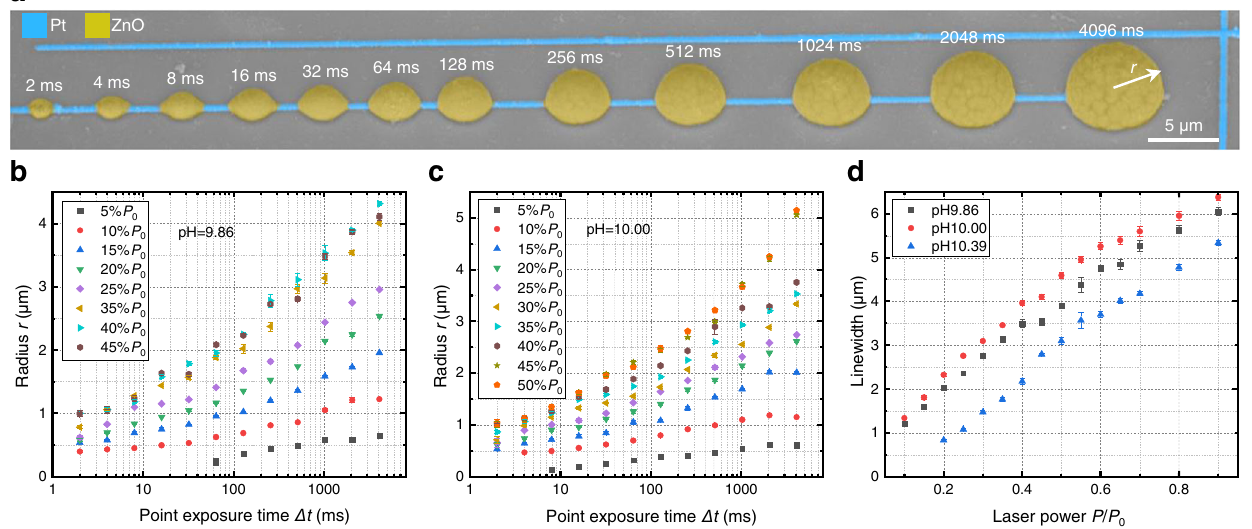
Fig. 2 | Controlling the geometry of laser-printed ZnO. a Scanning-electron micrograph of ZnO deposited on Pt wires by point exposure of a 532nm wave- length continuous-wave laser. The laser power is fi xed at P =30% P 0 , with : 5mW, while the exposure time increases from Δ t =2ms to 4096ms from P 0 =21 left to right. b , c Quantitative investigation of the geometrical size of laser-printed